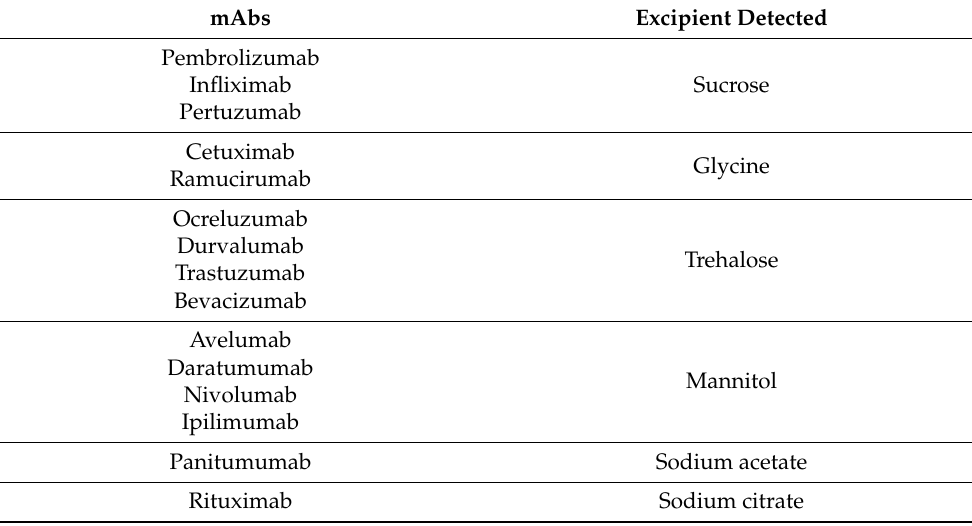
Table 2. Excipient list detected in the analyzed commercial